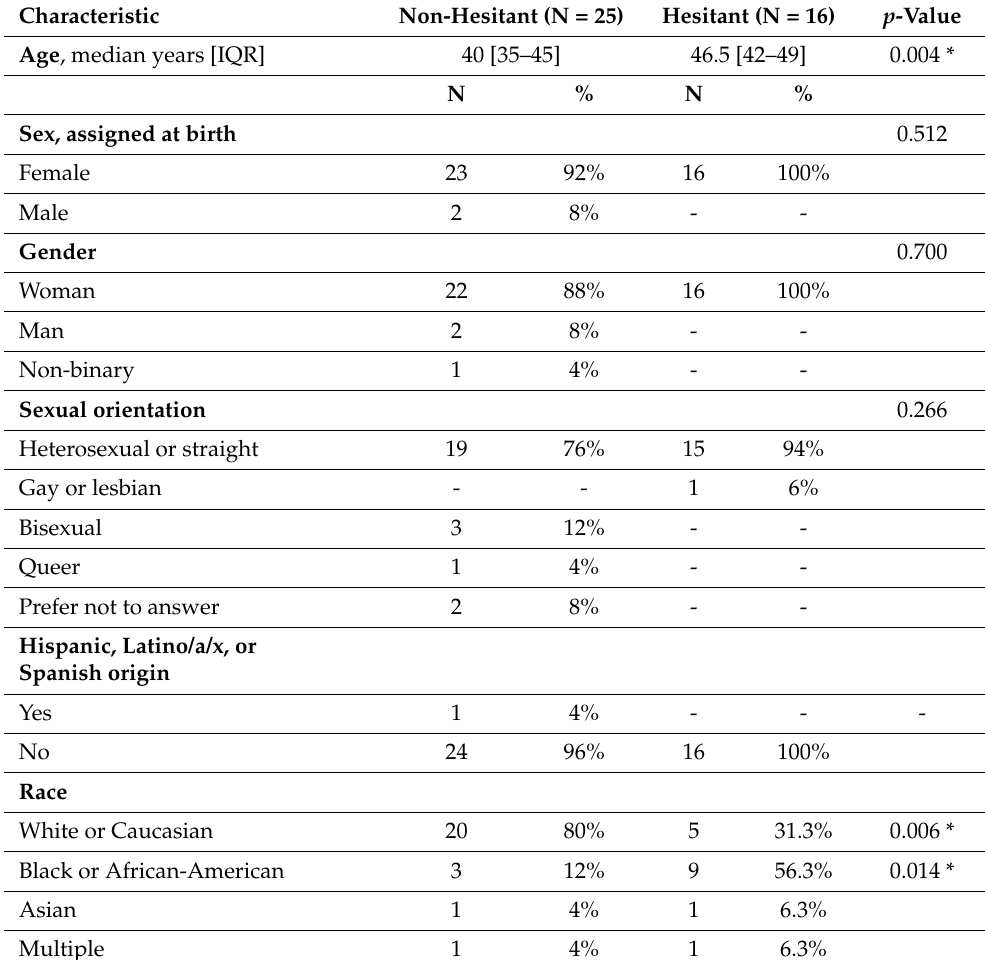
Table 2. Baseline sociodemographic and vaccination characteristics of focus group participants (N = 41) by vaccine hesitancy